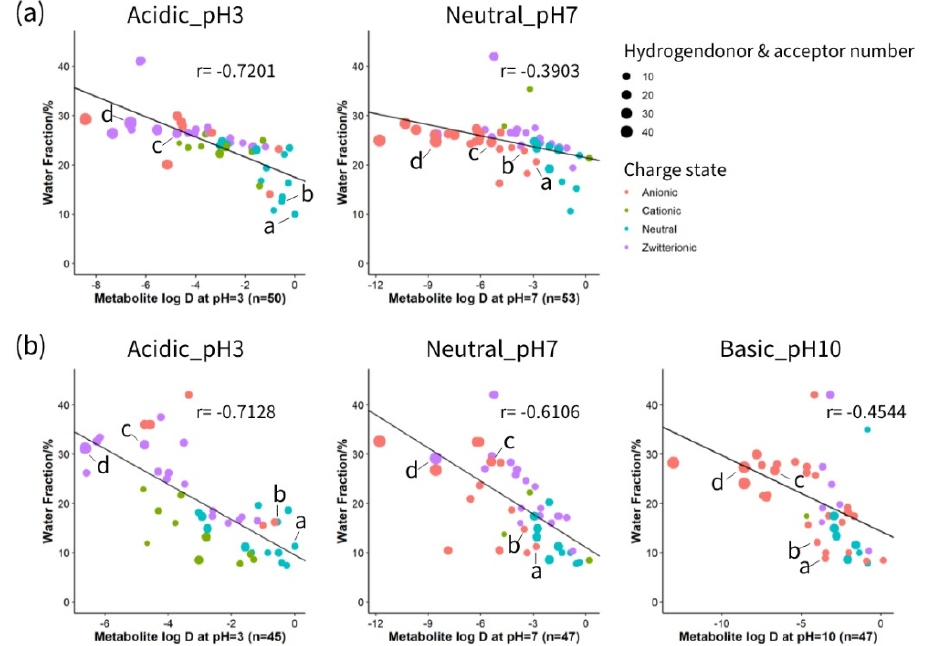
Figure 2. Analysis of the relative contribution to the retention mechanism on different HILIC columns. ( a ) Correlation analysis on ZIC-cHILIC and ( b ) Correlation analysis on BEH-amide. Individual metabolites are shown as a: 2-hydroxybutyric acid; b: lactic acid; c: AMP; d: NAD+.